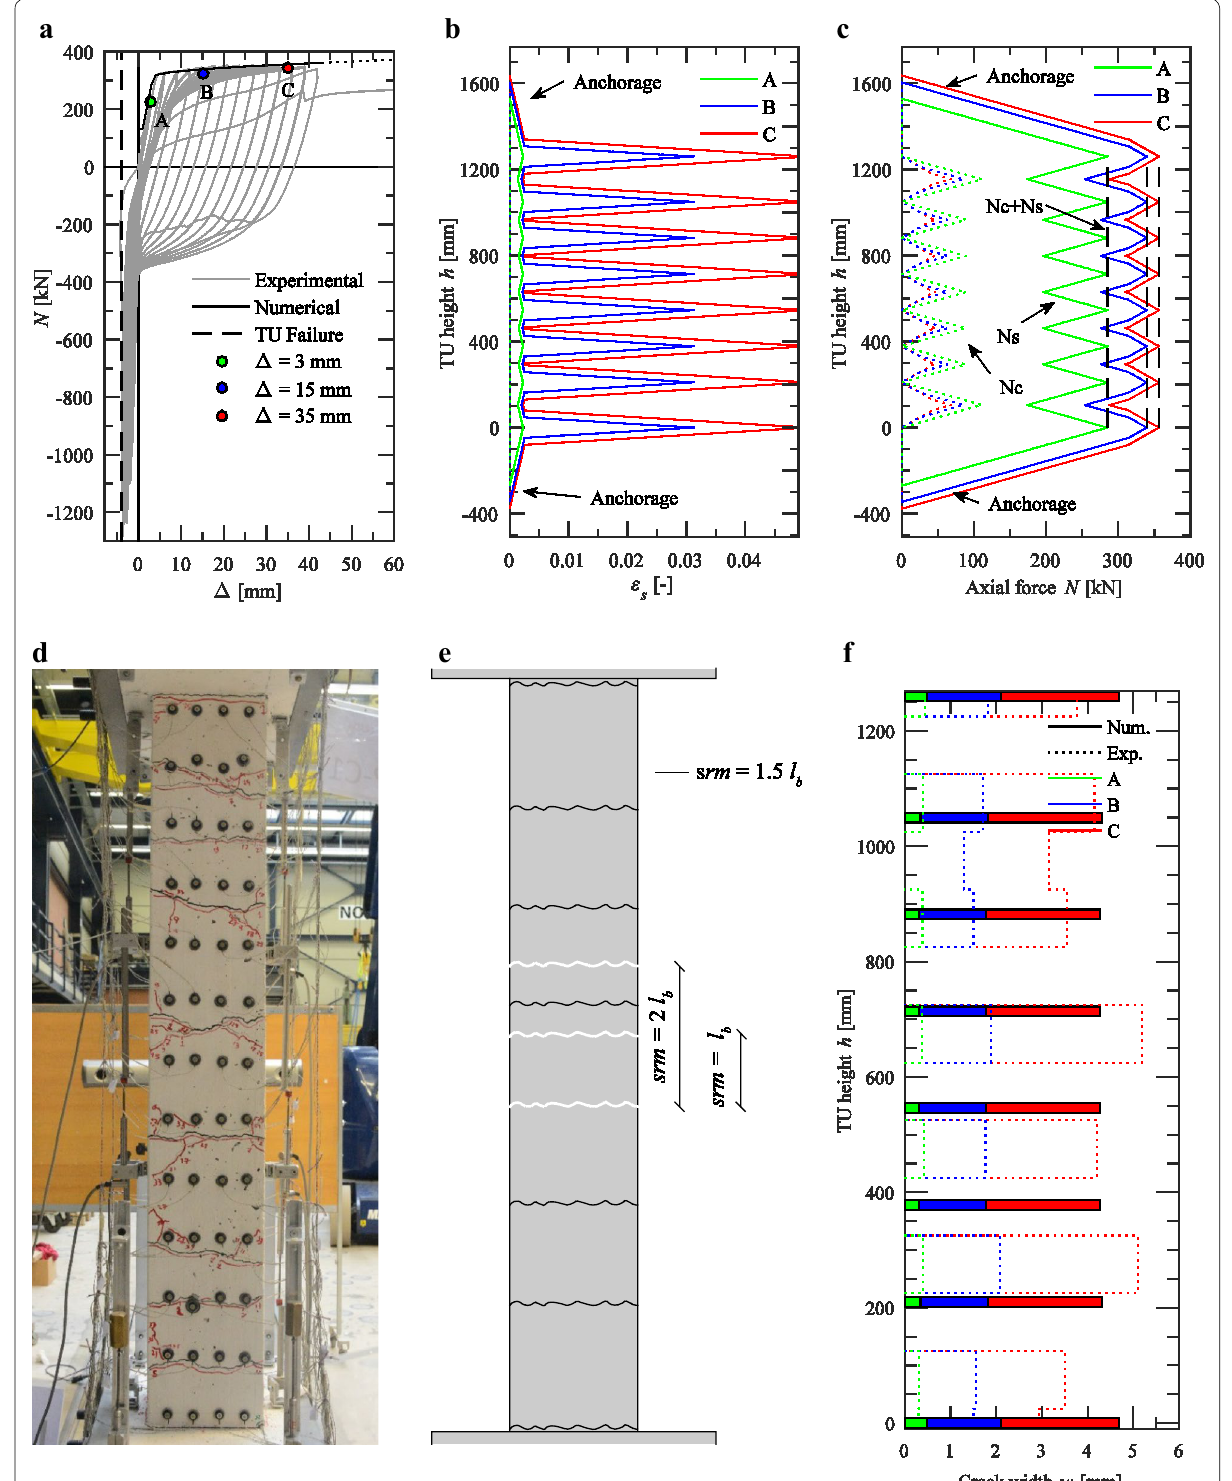
Fig. 9 Example of a test unit with continuous reinforcement (TU LAP-C1): a Experimental vs numerical force–displacement response. b Simulated steel strain profile. c Simulated steel and concrete force profiles. d Photo of crack pattern. e Numerical crack pattern obtained for different srm to l b ratios. f Experimental vs numerical crack